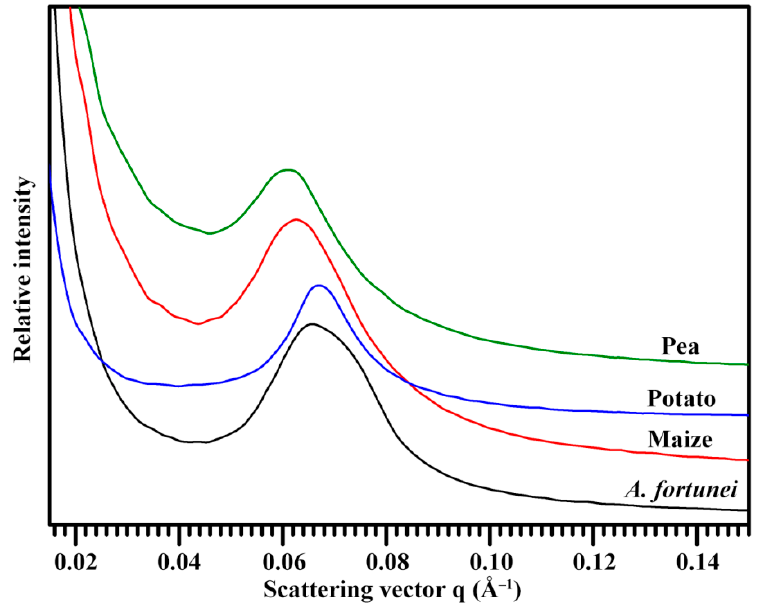
Figure 5. SAXS pattern of starch.